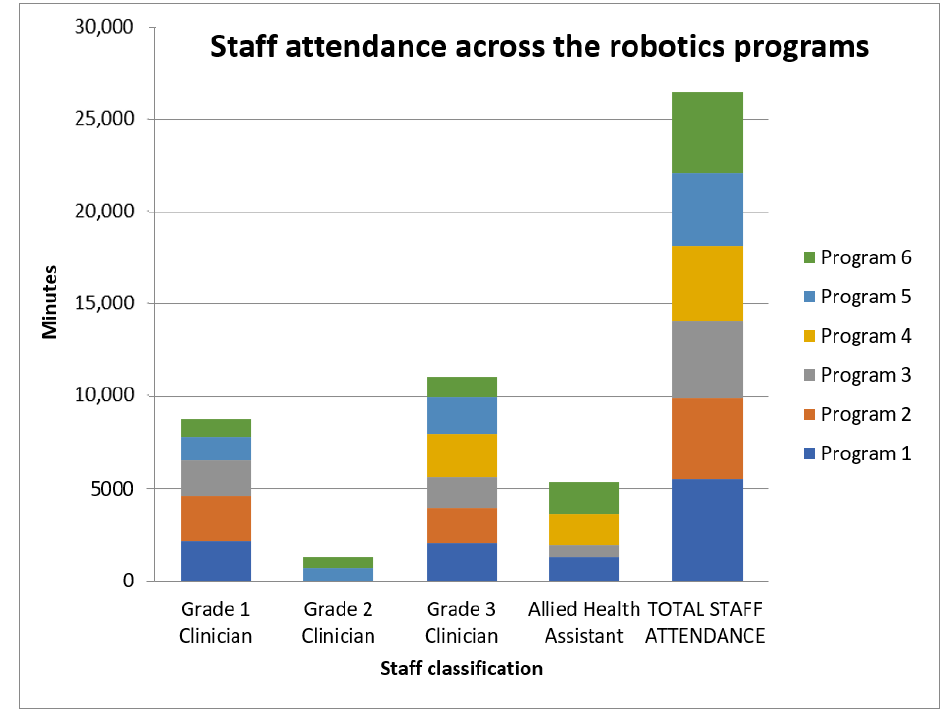
Figure 2. Staff attendance across the RBT program.